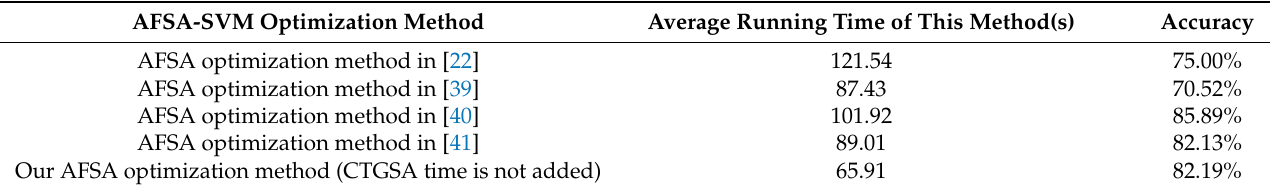
Table 1. Comparison of some AFSA-SVM optimization method